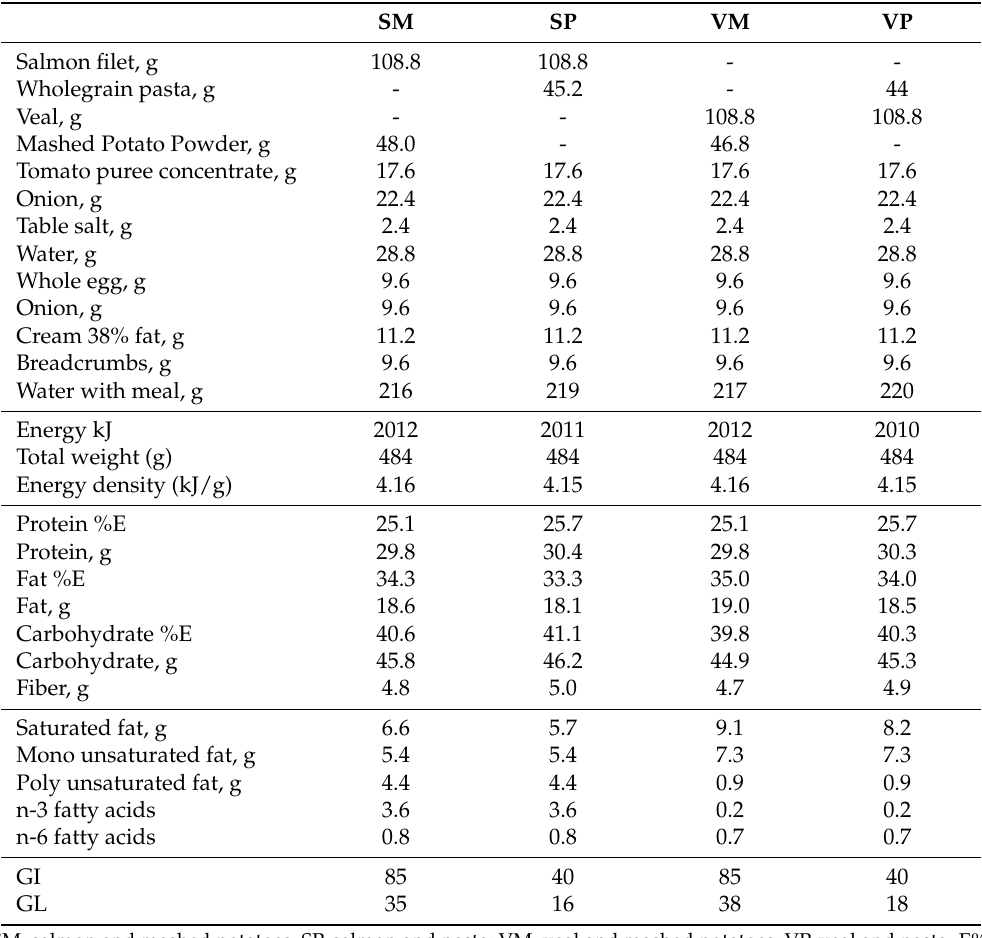
Table 1. Recipes and nutritional content of the four test meals.